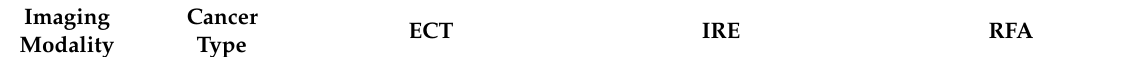
Table 2. Main imaging findings after ECT, IRE, RFA in pancreatic and liver